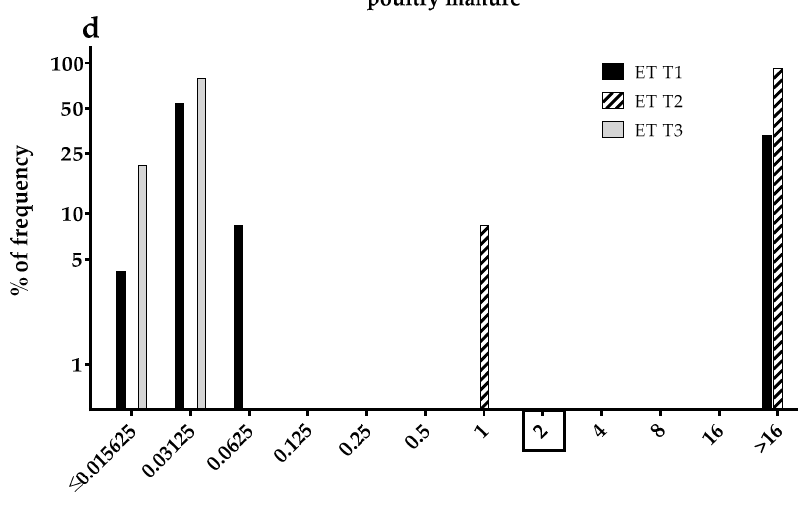
Figure 3. Percentage of frequency of enrofloxacin minimum inhibitory concentration (MIC) distribution in commensal E. coli isolates from ( a ) cloacal swabs after treatment (AT) and ( b ) end of trial (ET) as well as in ( c ) poultry manure samples during AT and ( d ) ET of untreated antibiotic (T1), treated twice with enrofloxacin via drinking water (T2) and simulated water spillage with water containing enrofloxacin (T3) in turkeys (cloacal swabs: N = 576; per trial AT: n = 96, ET: n = 96; poultry manure samples: N = 144; per trial AT: n = 24, ET: n = 24). Rectangle on the x-axis: Clinical Laboratory Standard Institute (CLSI) has determined a veterinary specific breakpoint of ≥ 2 μ g/mL enrofloxacin for E. coli from chickens and turkeys.